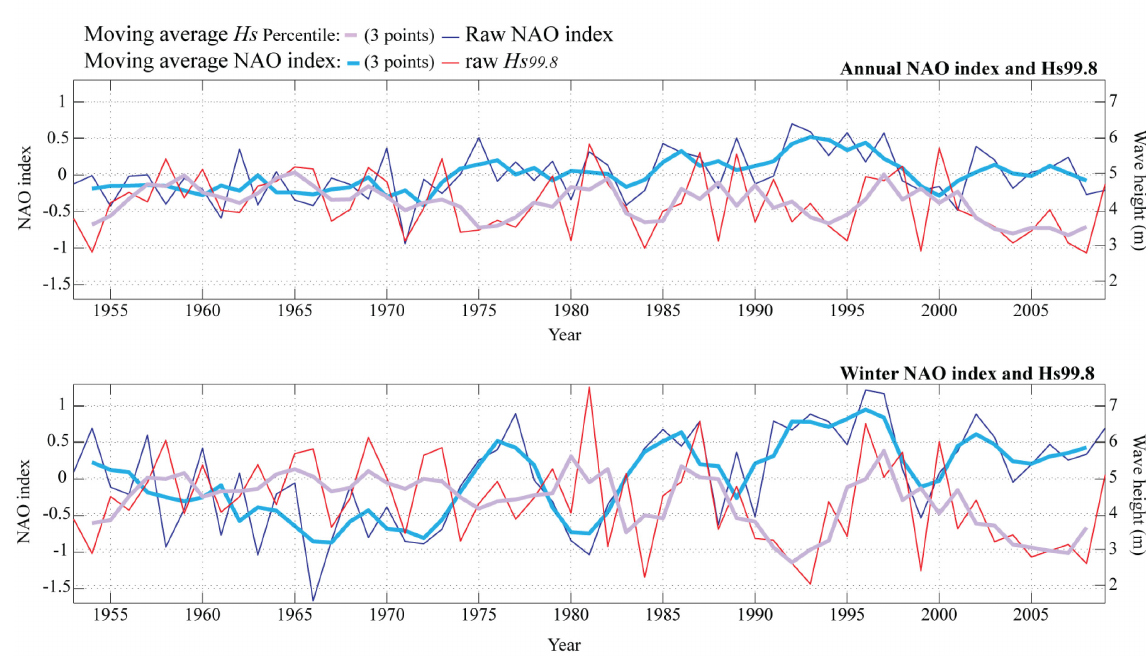
Fig. 6. NAO index versus H s99 . 8 using annual (A) and winter (B)